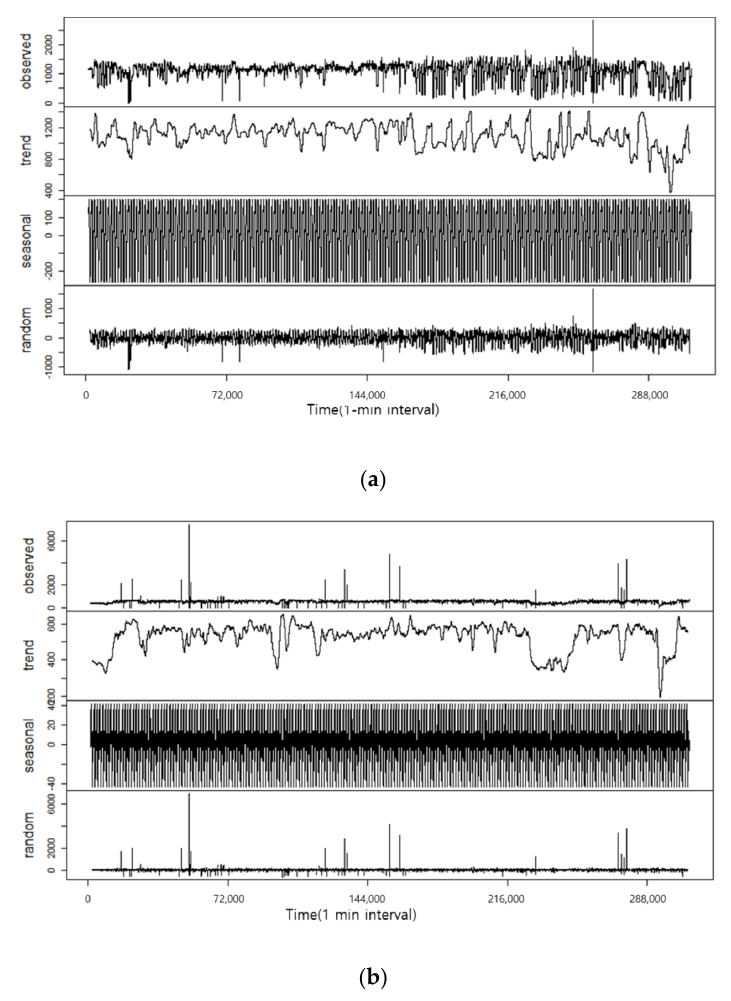
Figure 4. Decomposition of electricity demand data: ( a ) cement #1 and ( b ) cement #2 .